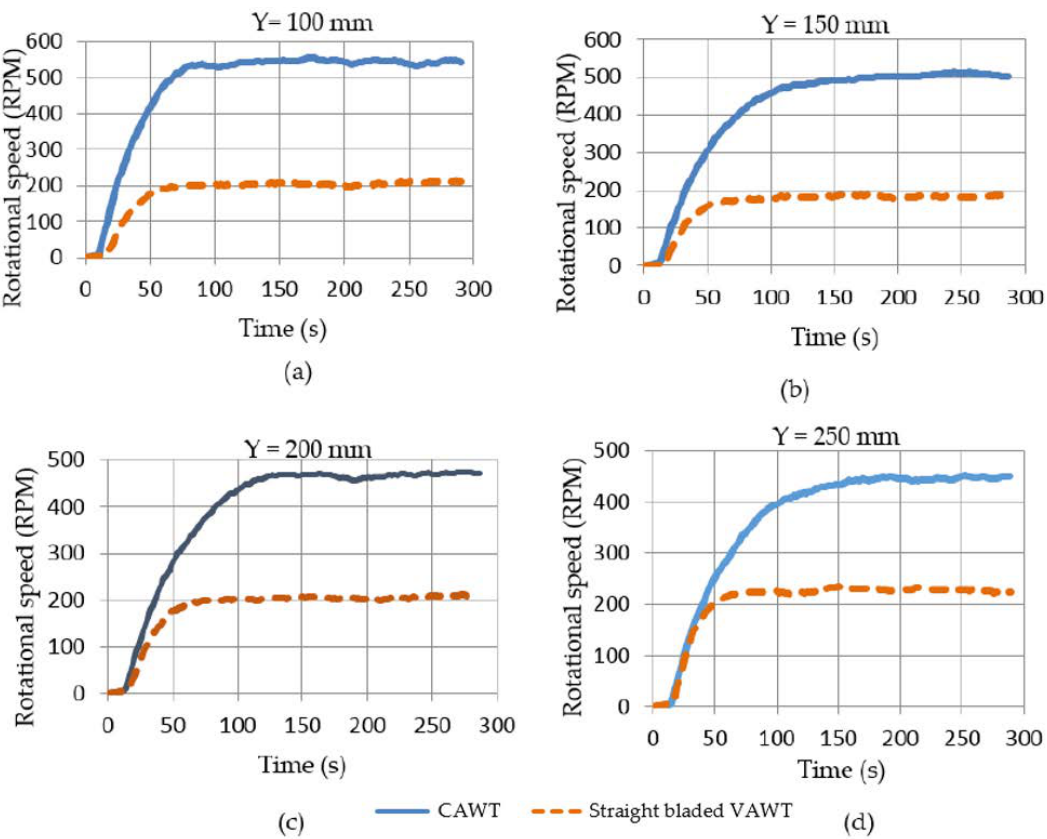
Figure 13. Rotational speed against time for building integrated CAWT and VAWT for